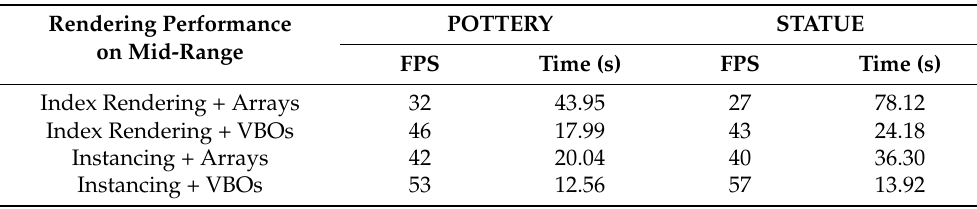
Table 12. Average frame rate and total rendering time of ten meshes of POTTERY and STATUE using a combination of rendering techniques and buffer storage on the mid-range